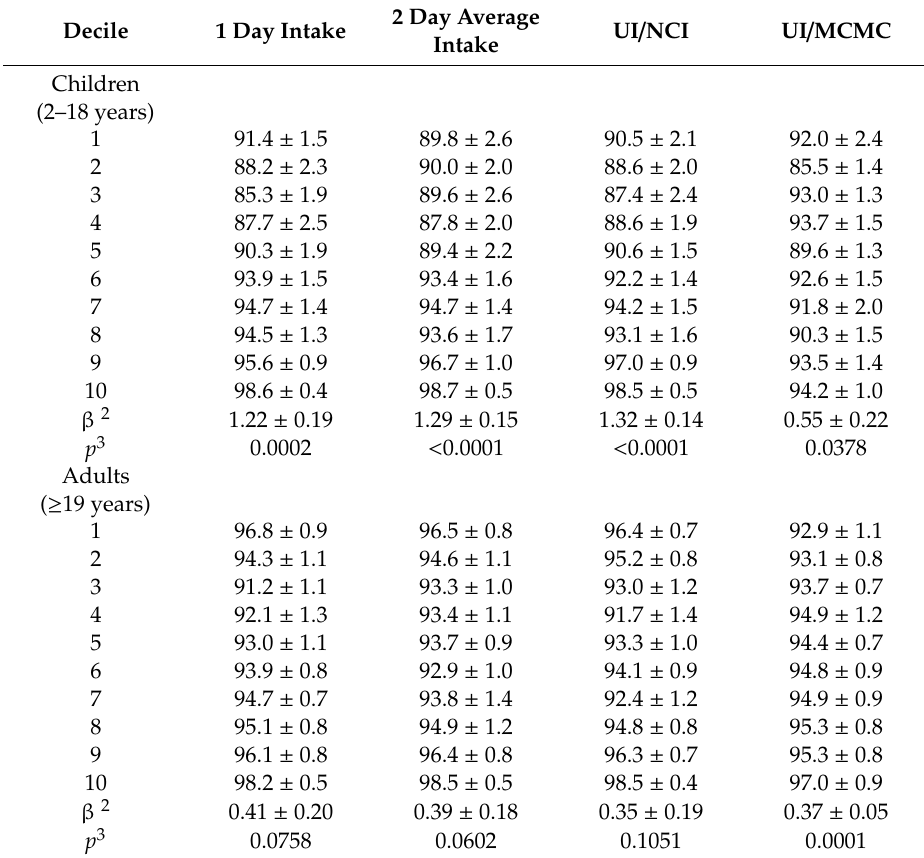
Table 5. Percentage of the population below the Estimated Average Requirement of vitamin D by deciles of added sugars intake by various methods, the NHANES 2011–2014.